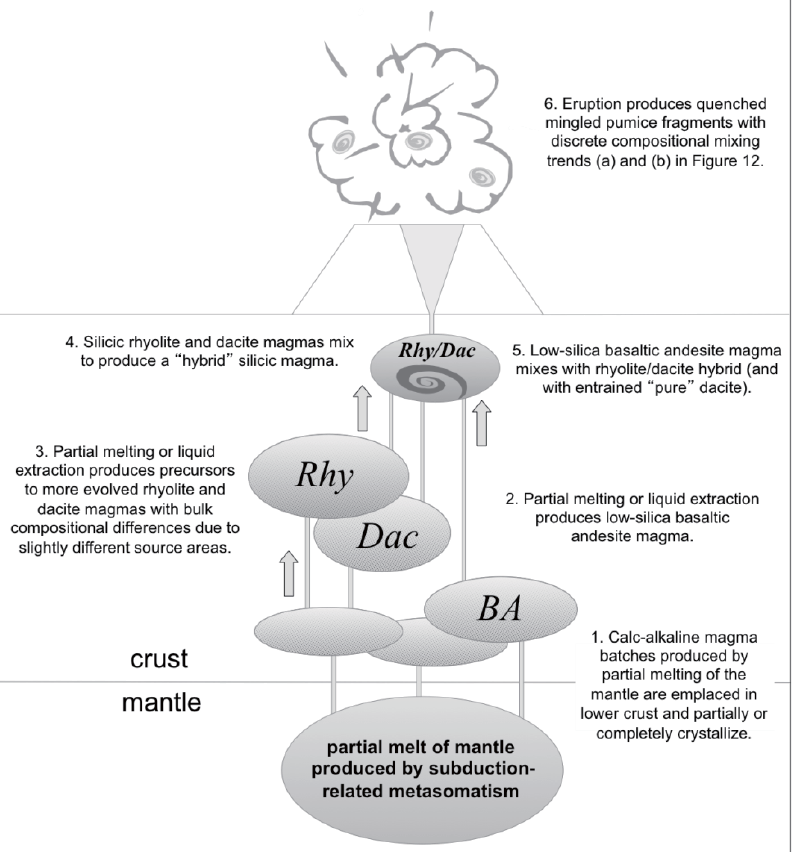
Figure 15. Schematic diagram for the petrogenesis of the Papagayo